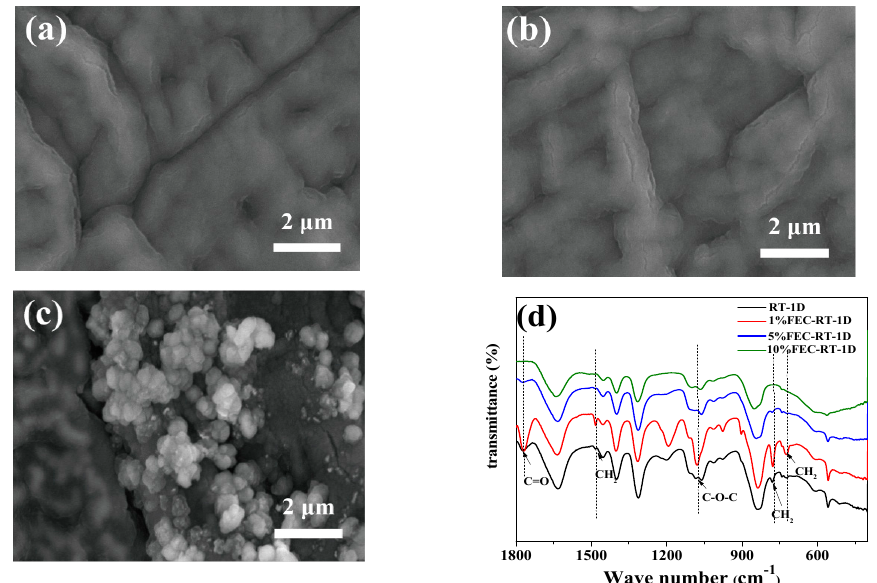
Figure 4. SEM images of lithium anodes: ( a ) 1%FEC-RT-1D, ( b ) 5%FEC-RT-1D and ( c ) 10%FEC-RT- 1D batteries; ( d ) FT-IR spectra of lithium anodes used in RT-1D, 1%FEC-RT-1D, 5%FEC-RT-1D and 10%FEC-RT-1D batteries.